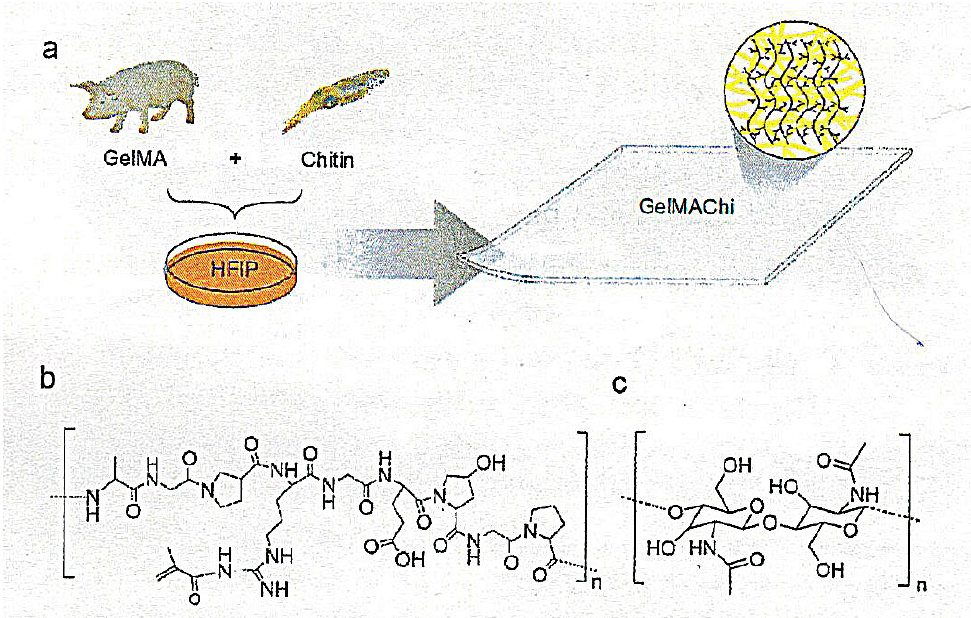
Figure 6. ( a ) Schematic illustration for the self-assembling process of the biomimetic ChNF-GelMA films; ( b ) molecular structure of GelMA; and ( c ) molecular structure of chitin (reprinted with permission from ref. [57]. Copyright 2016, Royal Society of Chemistry).